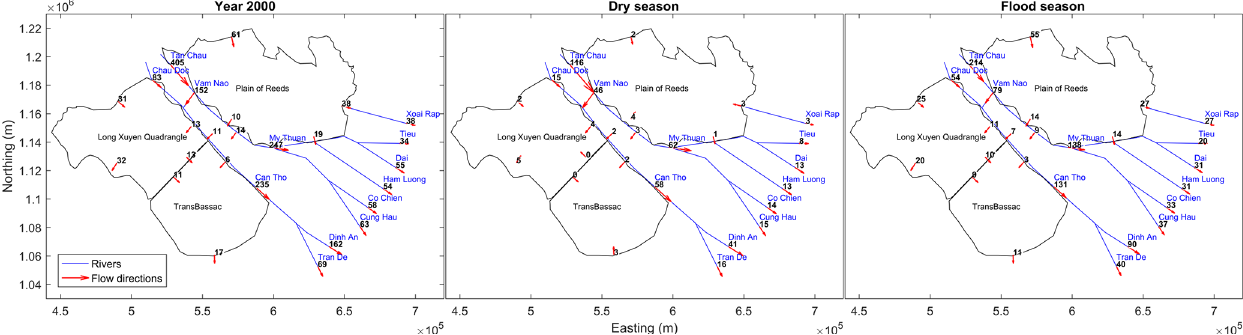
Figure 7. The spatial distribution of the water volume (km 3 ) throughout the VMD in 2000. The low-flow season is calculated from 1 January to 30 June and the high-flow season runs from 1 July to 30 October. Table 1. Calibrated values of the Manning roughness coefficient.